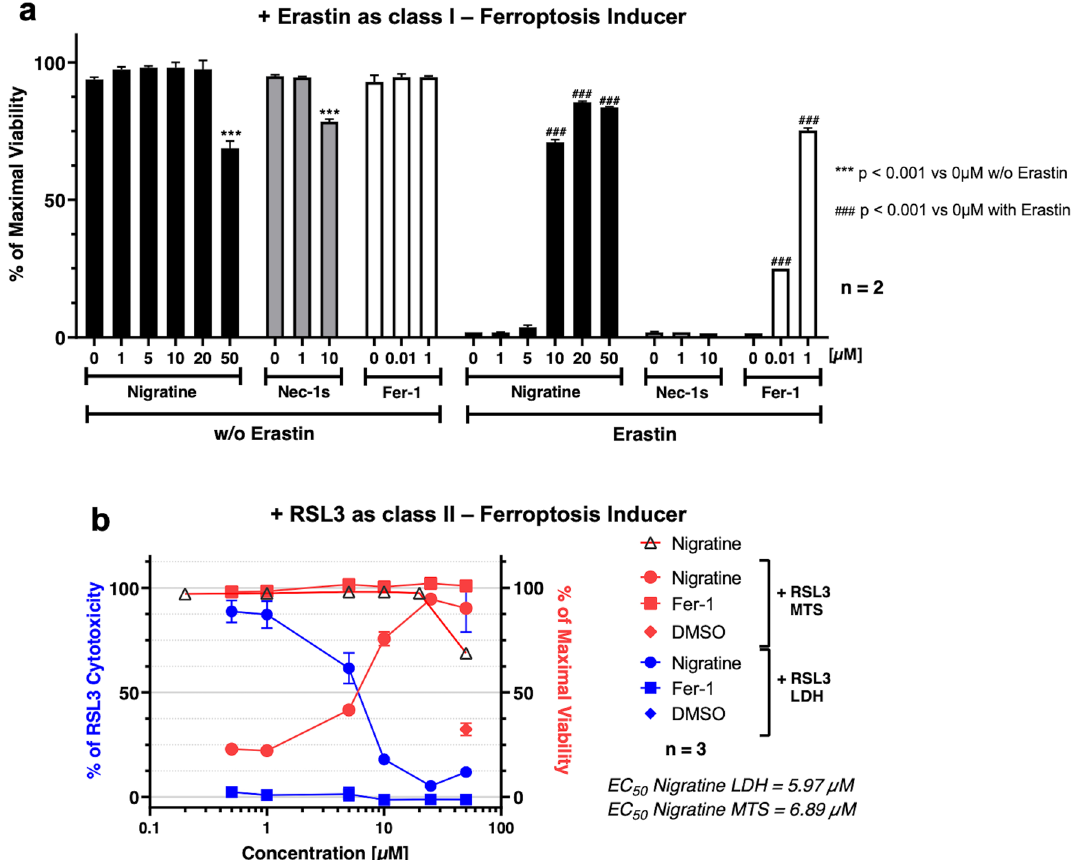
Figure 3. Nigratine protects SH-SY5Y human neuroblastoma cell line from cell death triggered by both class I and II-inducers of ferroptosis. ( a ) SH-SY5Y cells were co-treated 24 h with various concentrations of the tested chemical compounds alone and 10 µM of erastin. Ferrostatin-1 (Fer-1) was used as a positive control for ferroptosis inhibition. Cell viability was estimated by MTS assay. Data are shown as the mean ± SEM of two replicates. ( b ) SH-SY5Y cells were treated 24 h with 5 µM of RSL3 and increasing concentrations of nigratine or ferrostatin-1 (Fer-1). Cell death was evaluated by lactate dehydrogenase (LDH) release assay. Results are plotted in % of LDH release measured when cells are treated with RSL3 (left axis, colored blue). Cell viability was measured by MTS reduction assay. The results obtained (colored red) were plotted in % of maximal viability (detected in DMSO-treated cells, right axis). Data are shown as the mean ± SD of three